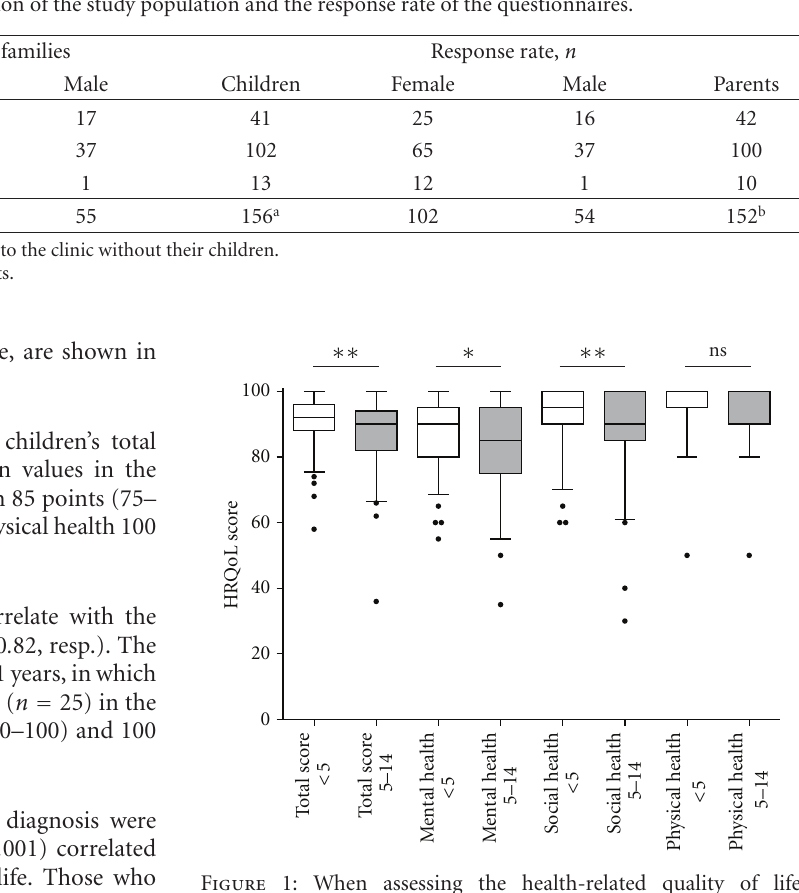
Figure 1: When assessing the health-related quality of life (HRQoL), using the DISABKIDS test, the children who received the diagnosis celiac disease before the age of five ( n = 93) ( < 5, open boxes) scored higher in the total test, as well as in the domains mental and social health, as compared to children who were five years or older at the time of diagnosis ( n = 63) (5–14, filled boxes). Box plot shows the median and 25th and 75th percentiles. Error bars represent 10th and 90th percentiles. ∗∗ P < 0 . 01; ∗ P < 0 . 05; ns: not